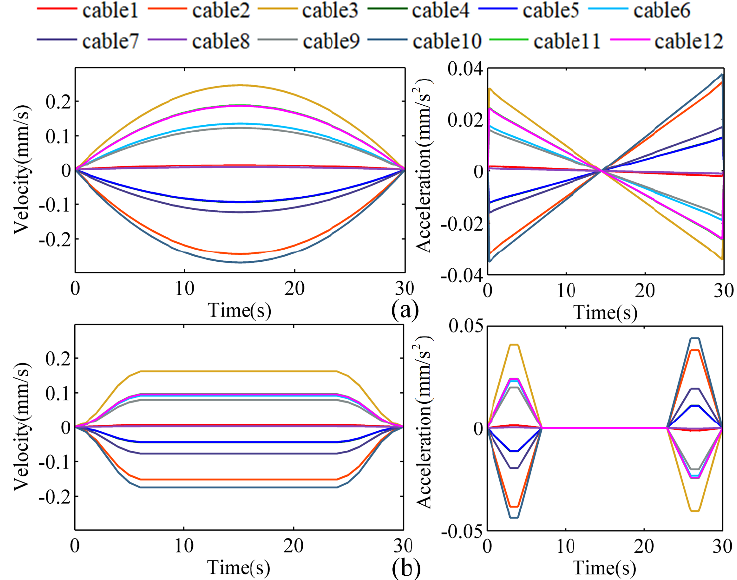
Figure 5. Velocity and acceleration curves of 12 cable − driven with different methods: ( a ) the iterative Jacobian method and ( b ) the convolutional dynamic-jerk-planning algorithm.